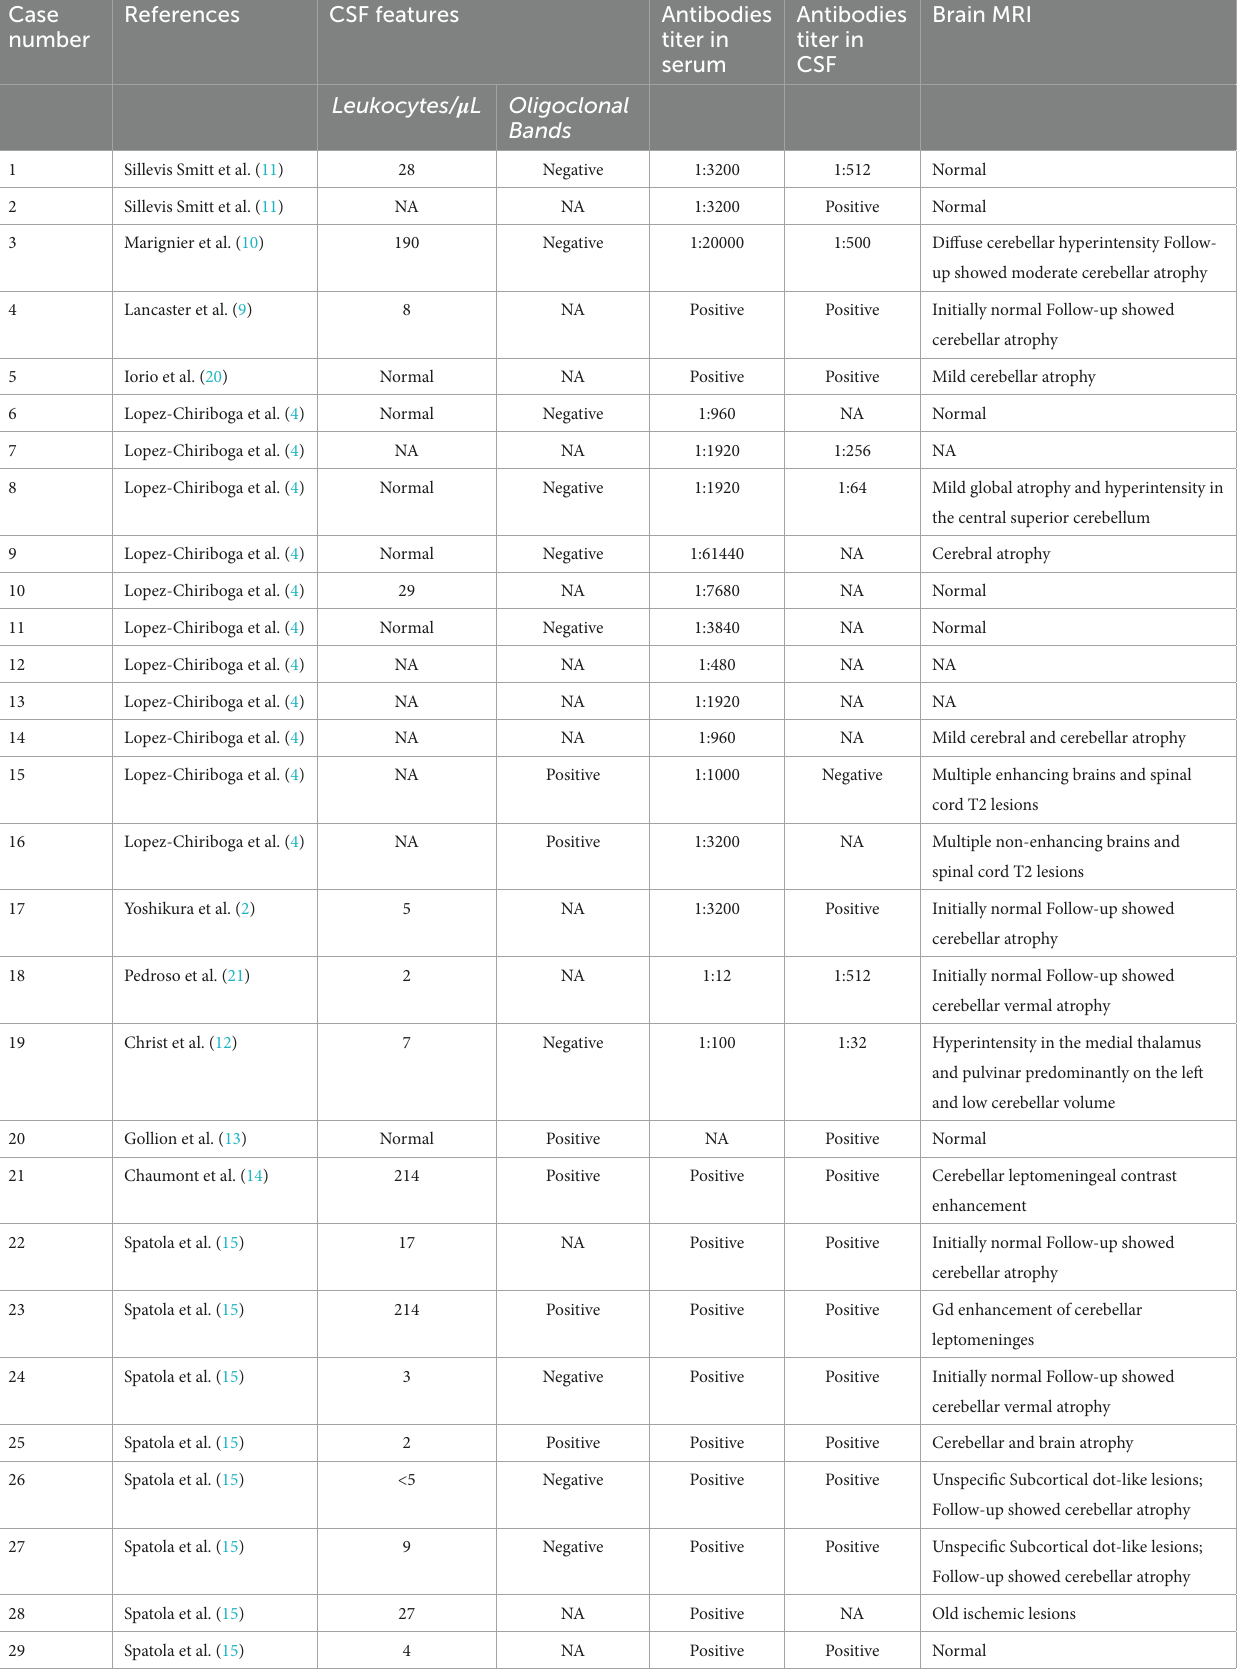
TABLE 3 Summary of the investigative findings of 36 patients diagnosed with anti-mGluR1 encephalitis. Case